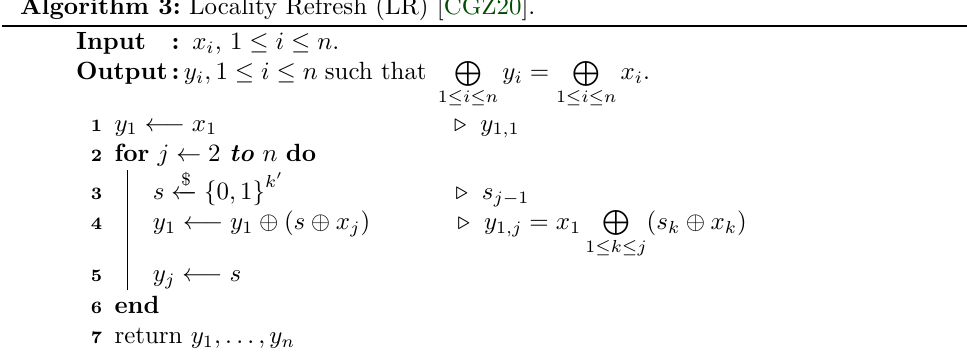
Algorithm 3: Locality Refresh (LR)